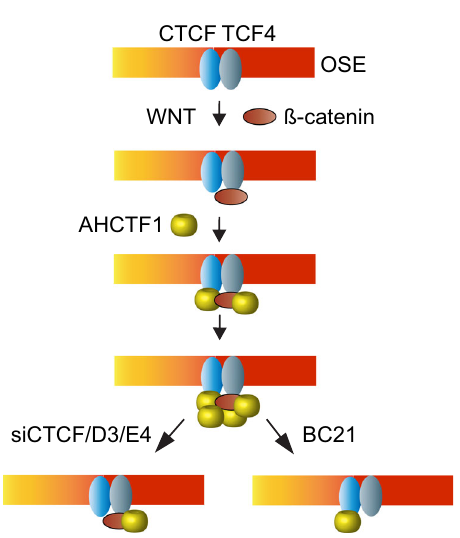
Fig. 4 Schematic model of the recruitment of AHCTF1 to the OSE-speci fi c CTCFBS. Both WT HCT-116 and D3/E4 cell clones displayed prominent TCF4/ß-catenin binding to the CCAT1 -speci fi c CTCFBS region, independently of the mutation in the CTCFBS (Supplementary Fig.